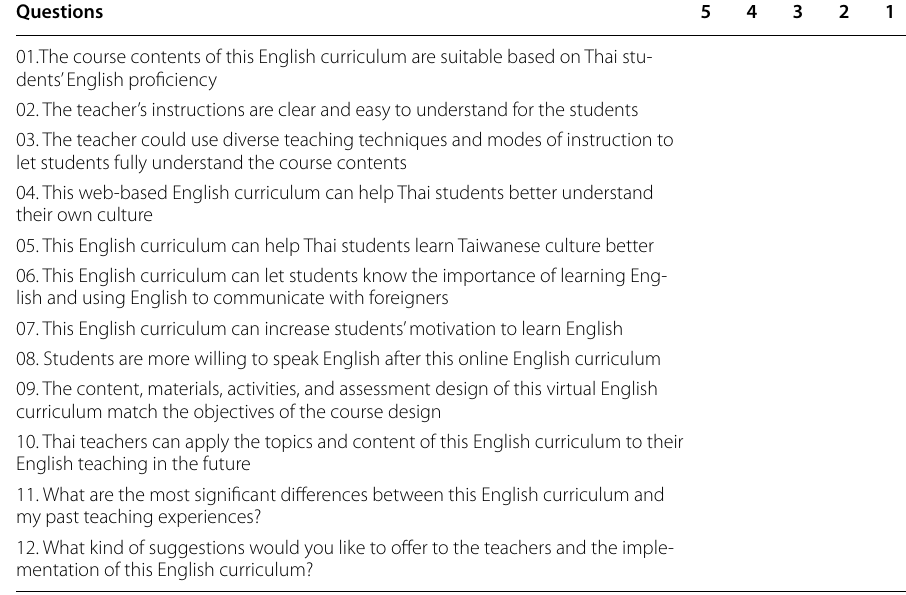
Strongly Agree (5); Agree (4); OK (3); Disagree (2); Strongly Disagree (1)